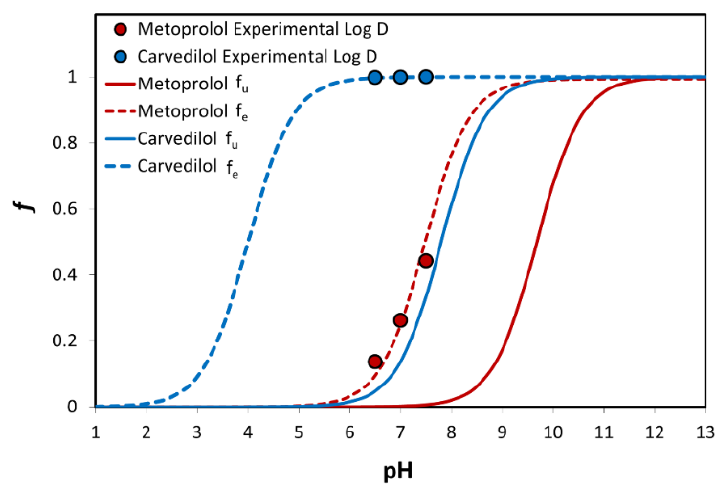
Figure 3. The theoretical fraction unionized (f u ) and fraction extracted into octanol (f e ) plots are presented as a function of pH for carvedilol and metoprolol. Log D values for both drugs are presented as circles; n = 6.